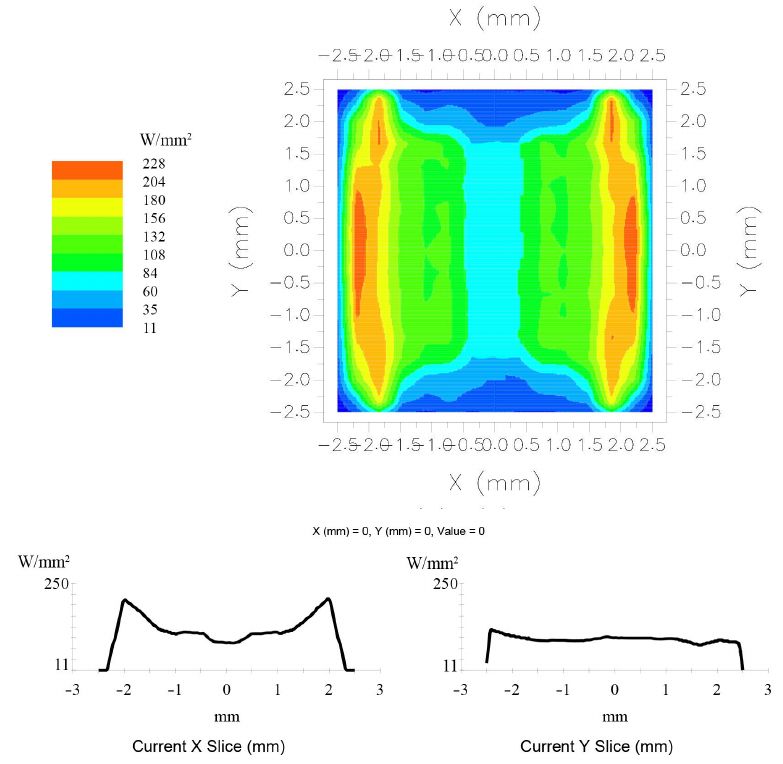
Figure 10. Irradiance distribution of 622× concentration over the solar cell.